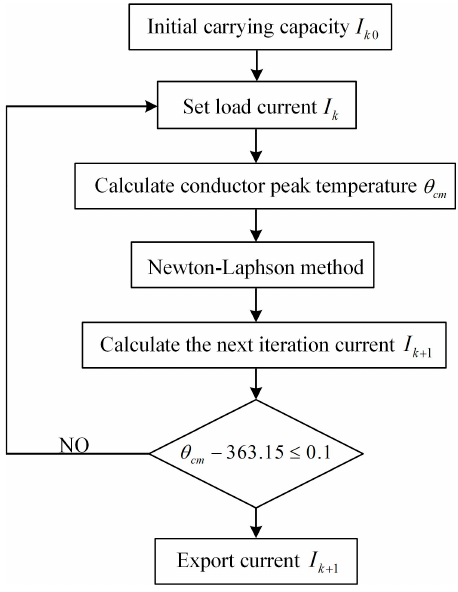
Figure 3. The flow chart of calculated ampacity.